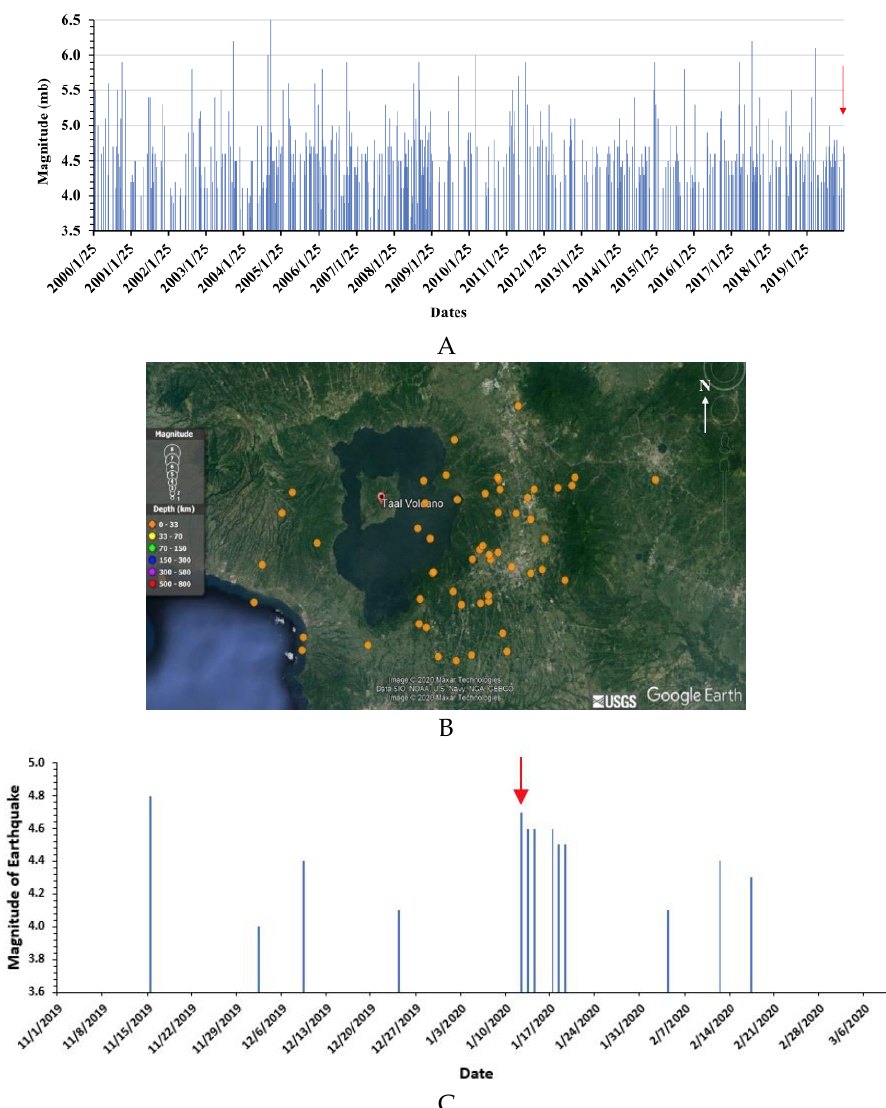
Figure 2. ( a ) Distribution of earthquakes within a 150 km radius around the Taal Volcano from 25 January 2000 – 10 February 2020. The volcanic eruptions started on 12 January 2020, as indicated by the red arrow. ( b ) Distribution of earthquakes with magnitude greater than 4.0 mb (yellow dots) within a 50 km radius around the Taal volcano from 1 November 2019 to 9 March 2020. Yellow dots show the distribution of earthquake epicenters. A total of 35 earthquakes occurred on 12 January 2020, and afterward, 18 earthquakes occurred on 13 January 2020. ( c ) Distribution of earthquake magnitudes greater than 4.0 mb within a radius of 50 km from 1 November 2019 to 9 March 2020 around the Taal Volcano, data are taken from the USGS website. Soon after the volcanic eruption (red arrow), the frequency of mild magnitude earthquakes increased. We do not have access to the local earthquake catalog, so we cannot comment on small earthquakes; however, a few earthquakes of magnitude around 4.0 and larger have been observed (source: USGS).